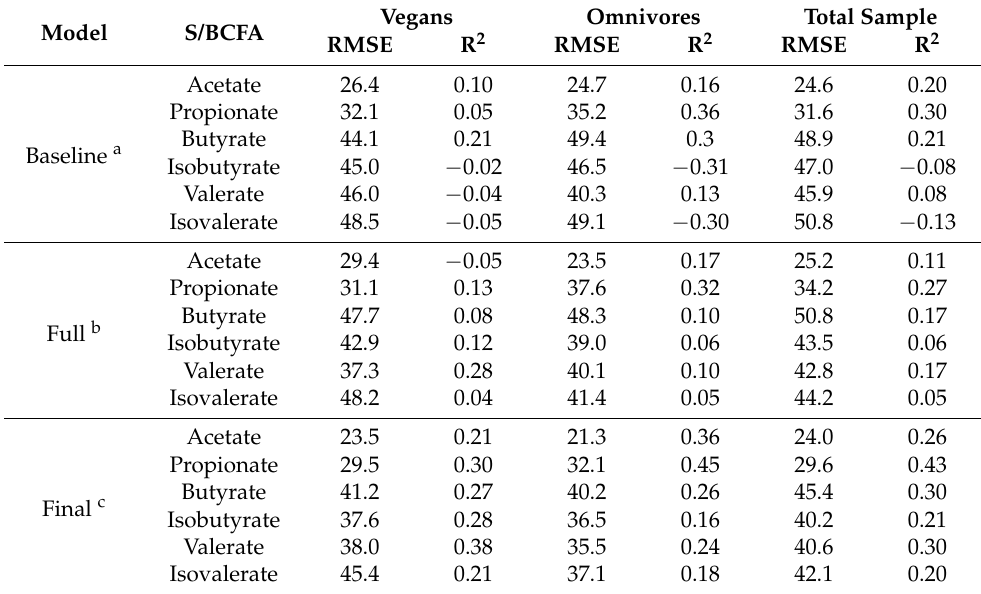
Table 4. Prediction performance of Random Forest regression models for SCFA and BCFA